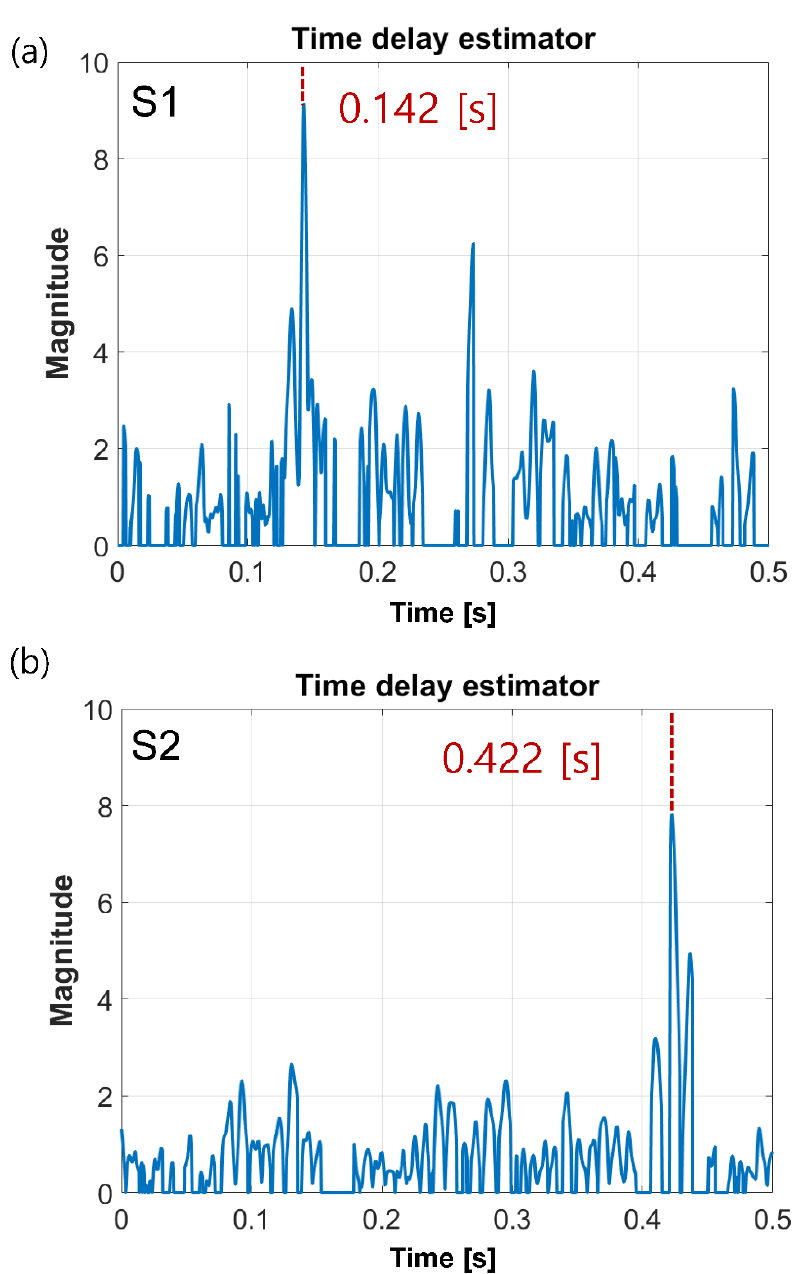
Figure 10. Wavelet − based time delay estimation of the signals measured at sensing points S1 ( a ) and S2 ( b ).